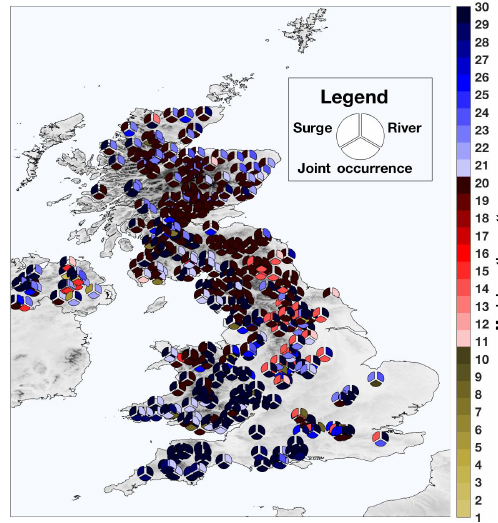
Figure 12. The modal weather-pattern type (indicated by the colours in the legend) for extreme surge only events (top left seg- ment), extreme river flow only events (top right segment), and ex- treme joint-occurrence events (bottom segment) observed at the study